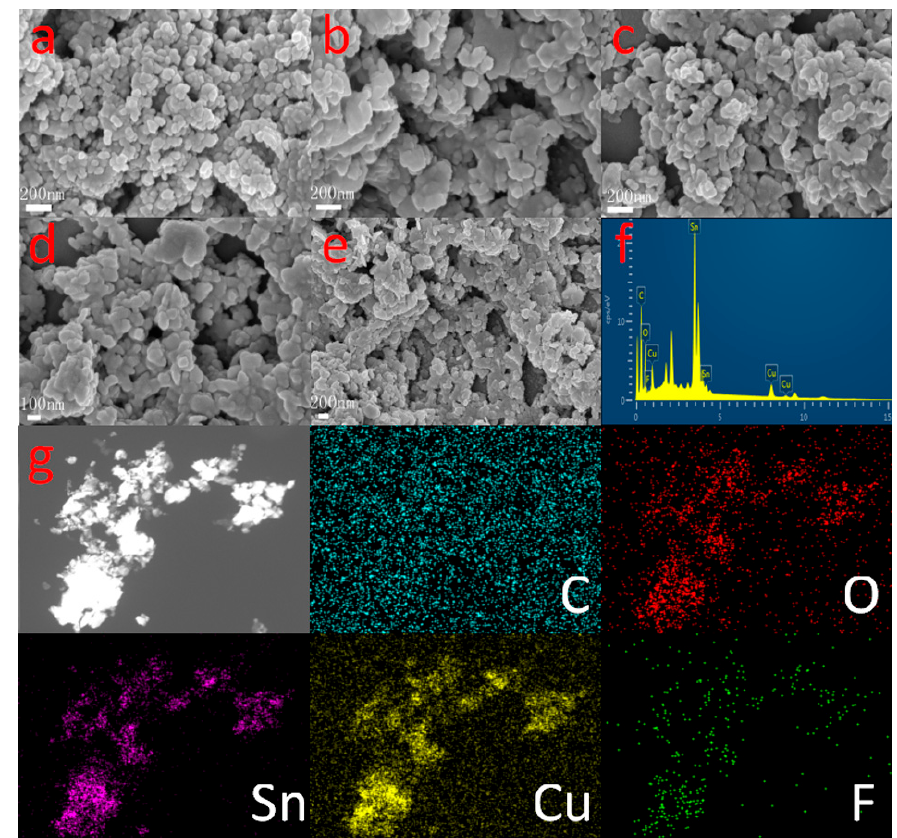
Figure 4. SEM (scanning electron microscopy) images ( a ) FTO; ( b ) 7.4% Cu/FTO; ( c , d ) 19.2% Cu/FTO; ( e ) 28.4% Cu/FTO; EDX (energy dispersive X-ray) spectrum ( f ); and elemental mapping patterns ( g ) of the 19.2% Cu/FTO sample.